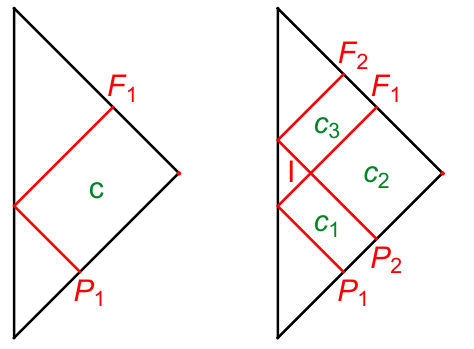
Figure 8 . Discrete versions of the wave equation with one (resp. two) points on the past boundary shown on the left (resp.